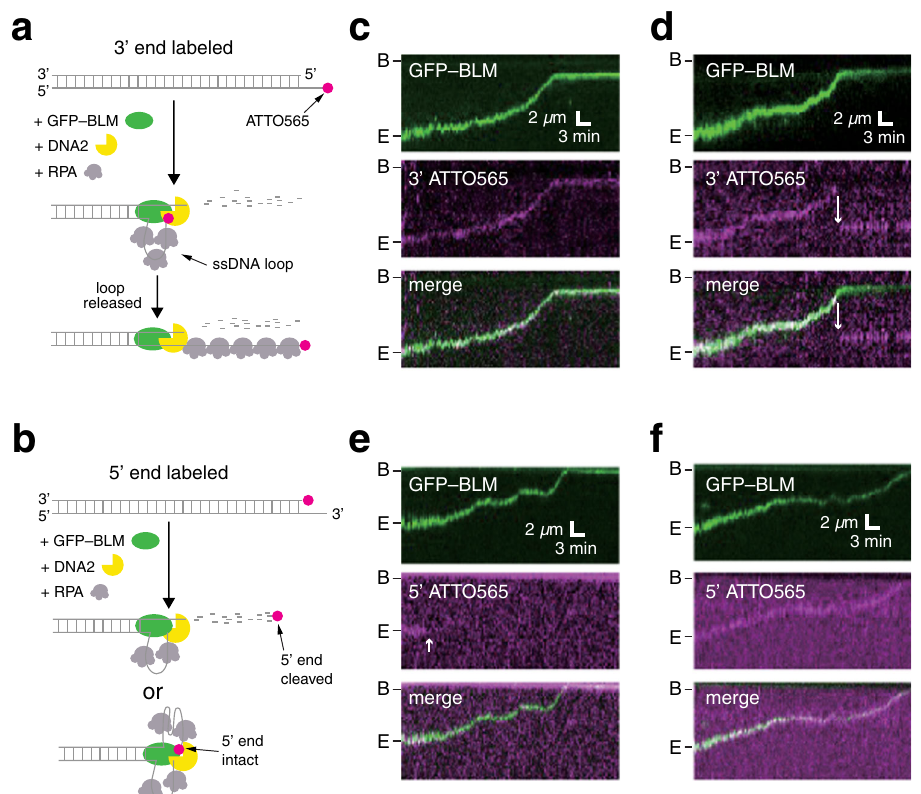
Fig. 2 Fate of the 3 ′ and 5 ′ DNA ends during end resection. a Schematic of end resection with a 3 ′ ATTO565 end-labeled DNA substrate. b Schematic of end resection with a 5 ′ ATTO565 end-labeled DNA substrate. c Kymograph showing an example where the 3 ′ ATTO565 label (magenta) tracks with GFP- BLM (green) during DNA end resection. d Kymograph showing an example where the 3 ′ ATTO565 label (magenta) initially tracks with GFP-BLM (green) during DNA end resection but is then released from the protein complex; release of the end is highlighted with an arrowhead. e Kymograph showing an example where the 5 ′ ATTO565 label (magenta) is lost at the onset of DNA end resection. f Kymograph showing an example where the 5 ′ ATTO565 label (magenta) tracks with GFP-BLM (green) during end resection. All reactions contained 0.2 nM GFP-BLM, 0.2 nM DNA2 and 2 nM